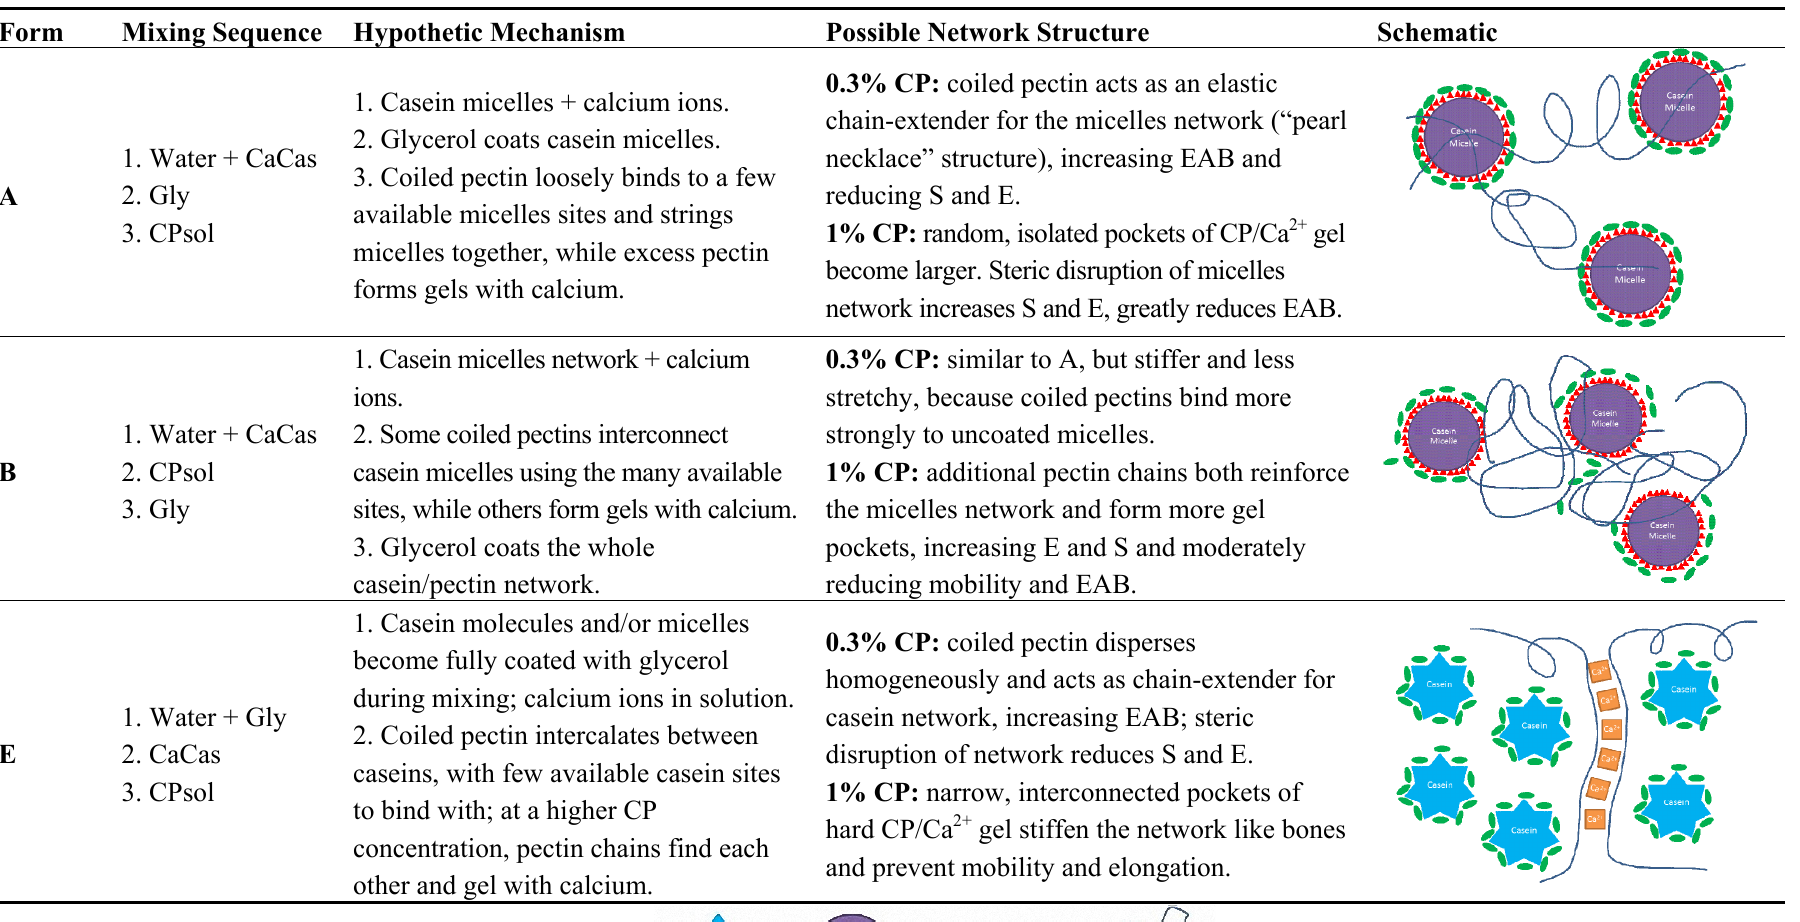
Table 4. The proposed mechanism of the formation and structure of CaCas/Gly/CP film networks, for Formulations A through G with 0.3% or 1.0%